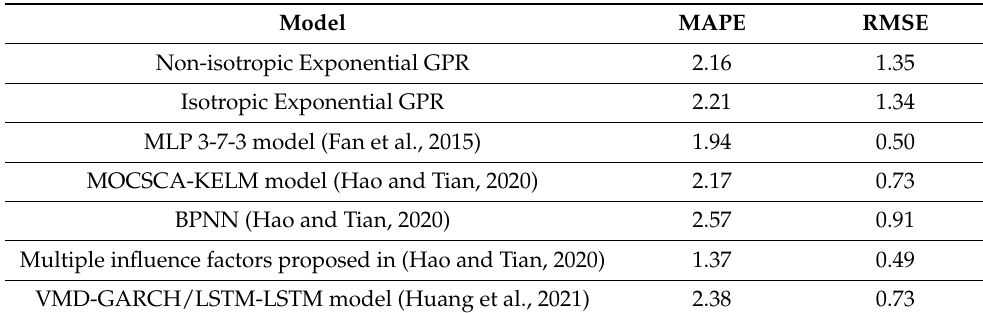
Table 4. Comparison of EUA prediction models.